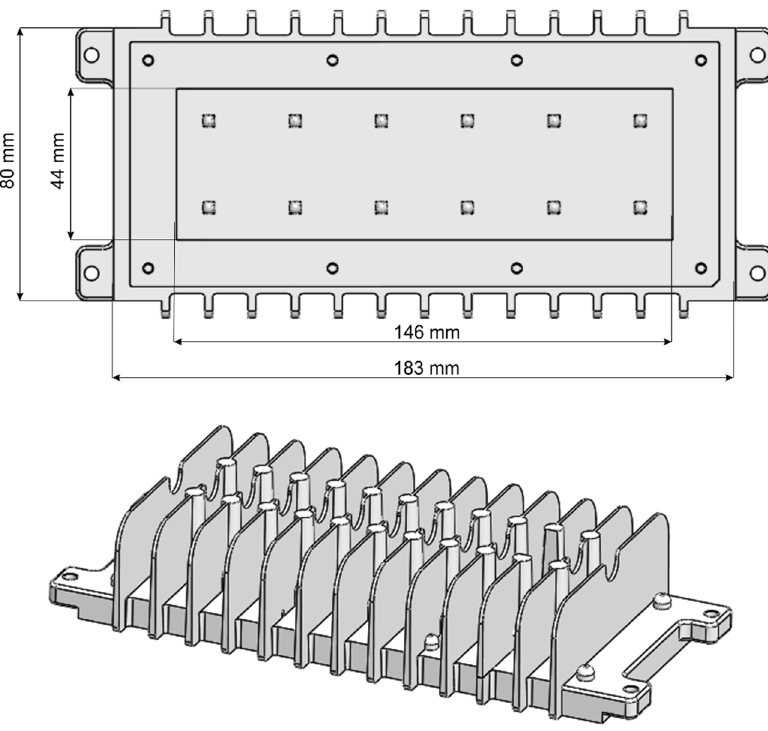
Figure 7. Computer model of the tested LED panel.